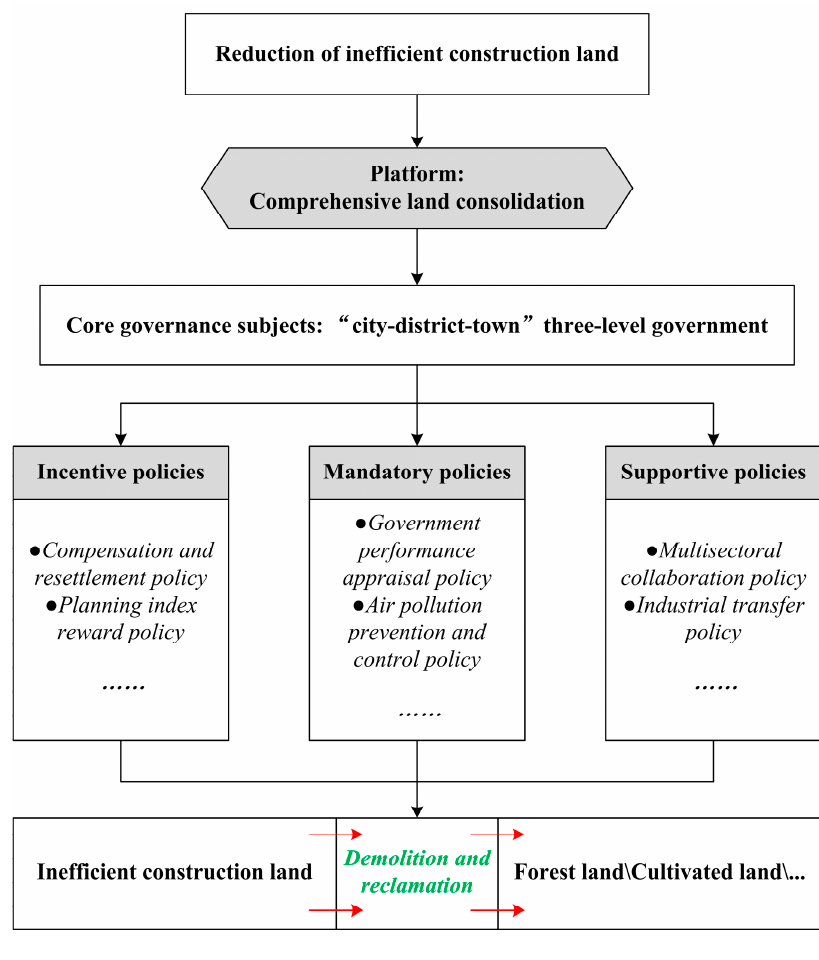
Figure 7. Implementation mechanism of inefficient construction land reduction.